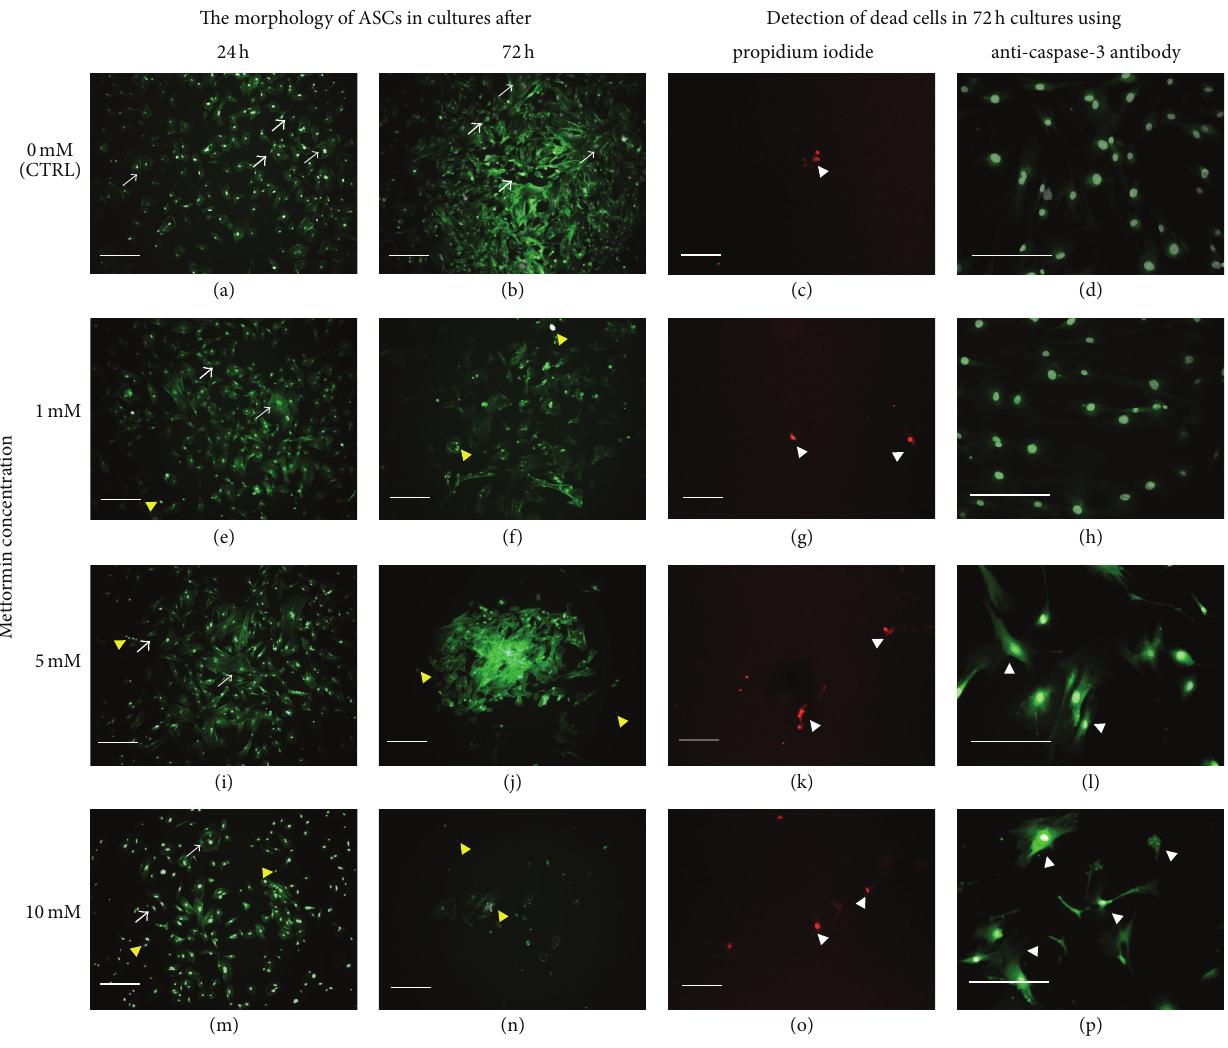
Figure 4: The morphological changes of ASCs after 24 and 72 hours in the cultures treated with 1mM ((e) and (f)), 5mM ((i) and (j)), and 10mM ((m) and (n)) of metformin in comparison to the control cultures ((a) and (b)). The graphs provided are representative, showing characteristic features of investigated cultures. The ASCs cultures were characterized by the presence of small (representative indicated with thin arrows) and larger cells (representative indicated with thick arrows). Actin cytoskeleton was visualized using atto-488 phalloidin (green- stained cell bodies), while nuclei were visualized with DAPI stating (white dots). Apoptotic bodies occurred in cultures were indicated with yellow arrowheads, while dead cells were indicated with white arrowheads. Dead cells identified with propidium iodide are red-stained, while caspase-3 positive cells are green-stained. Magnification used is 50x, and scale bar is 200 𝜇